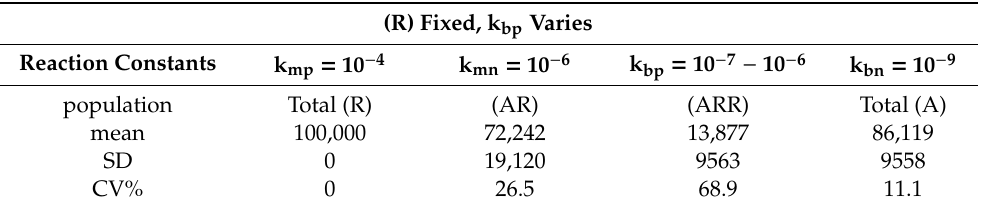
Table 6. Model calculation results for fluctuating bivalent binding.